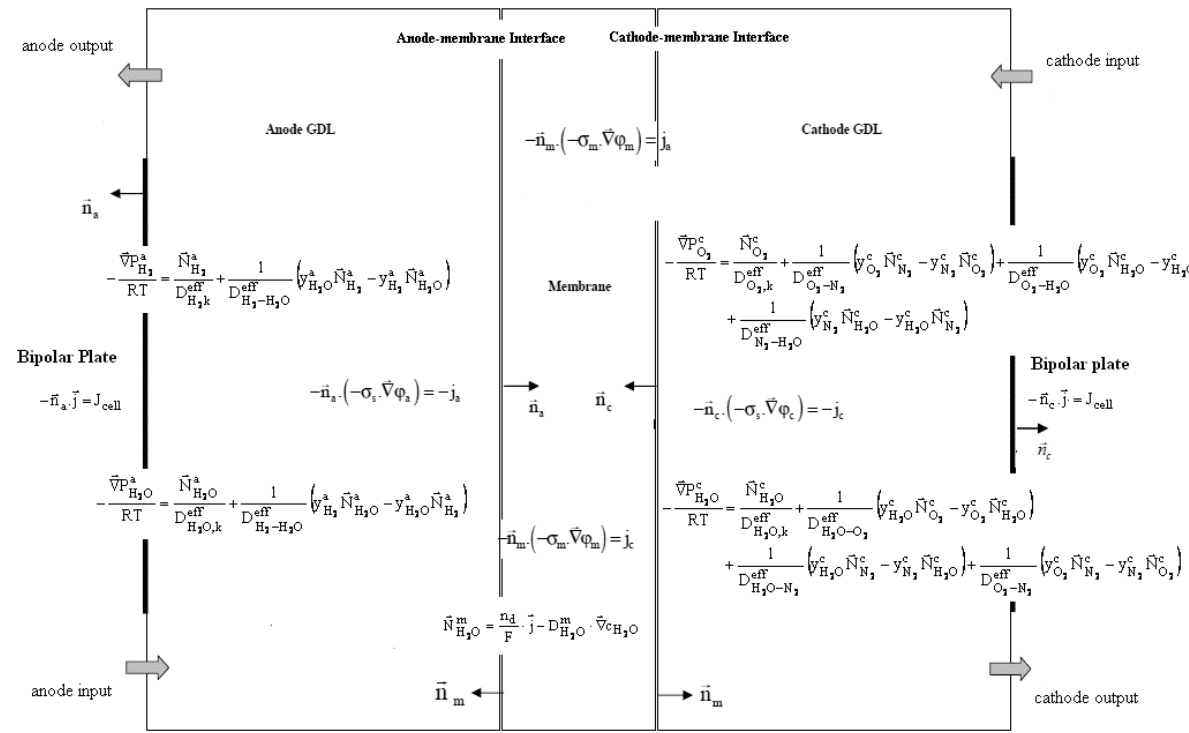
Figure 7. Coupled partial differential equations of an